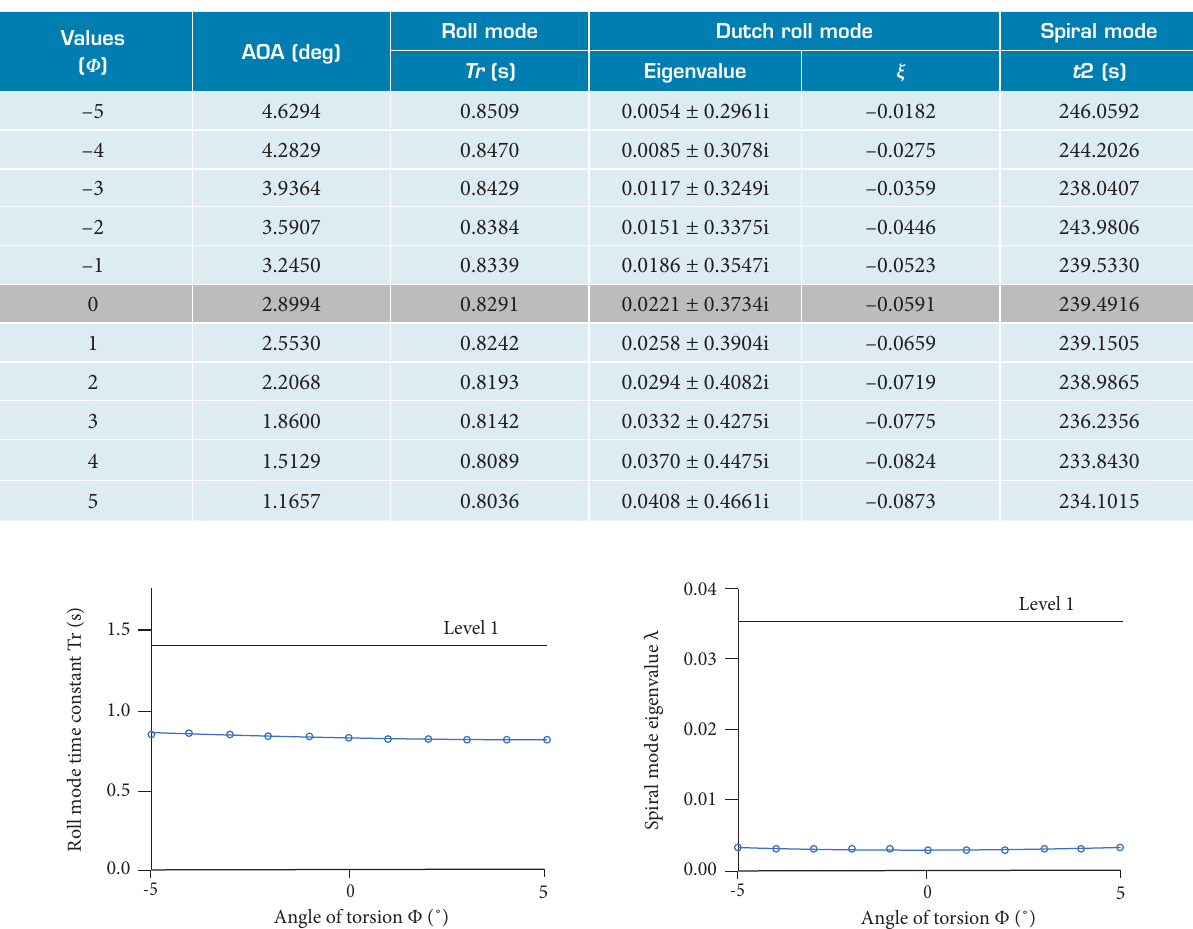
Table 6. Influence of Φ on lateral-directional stability.